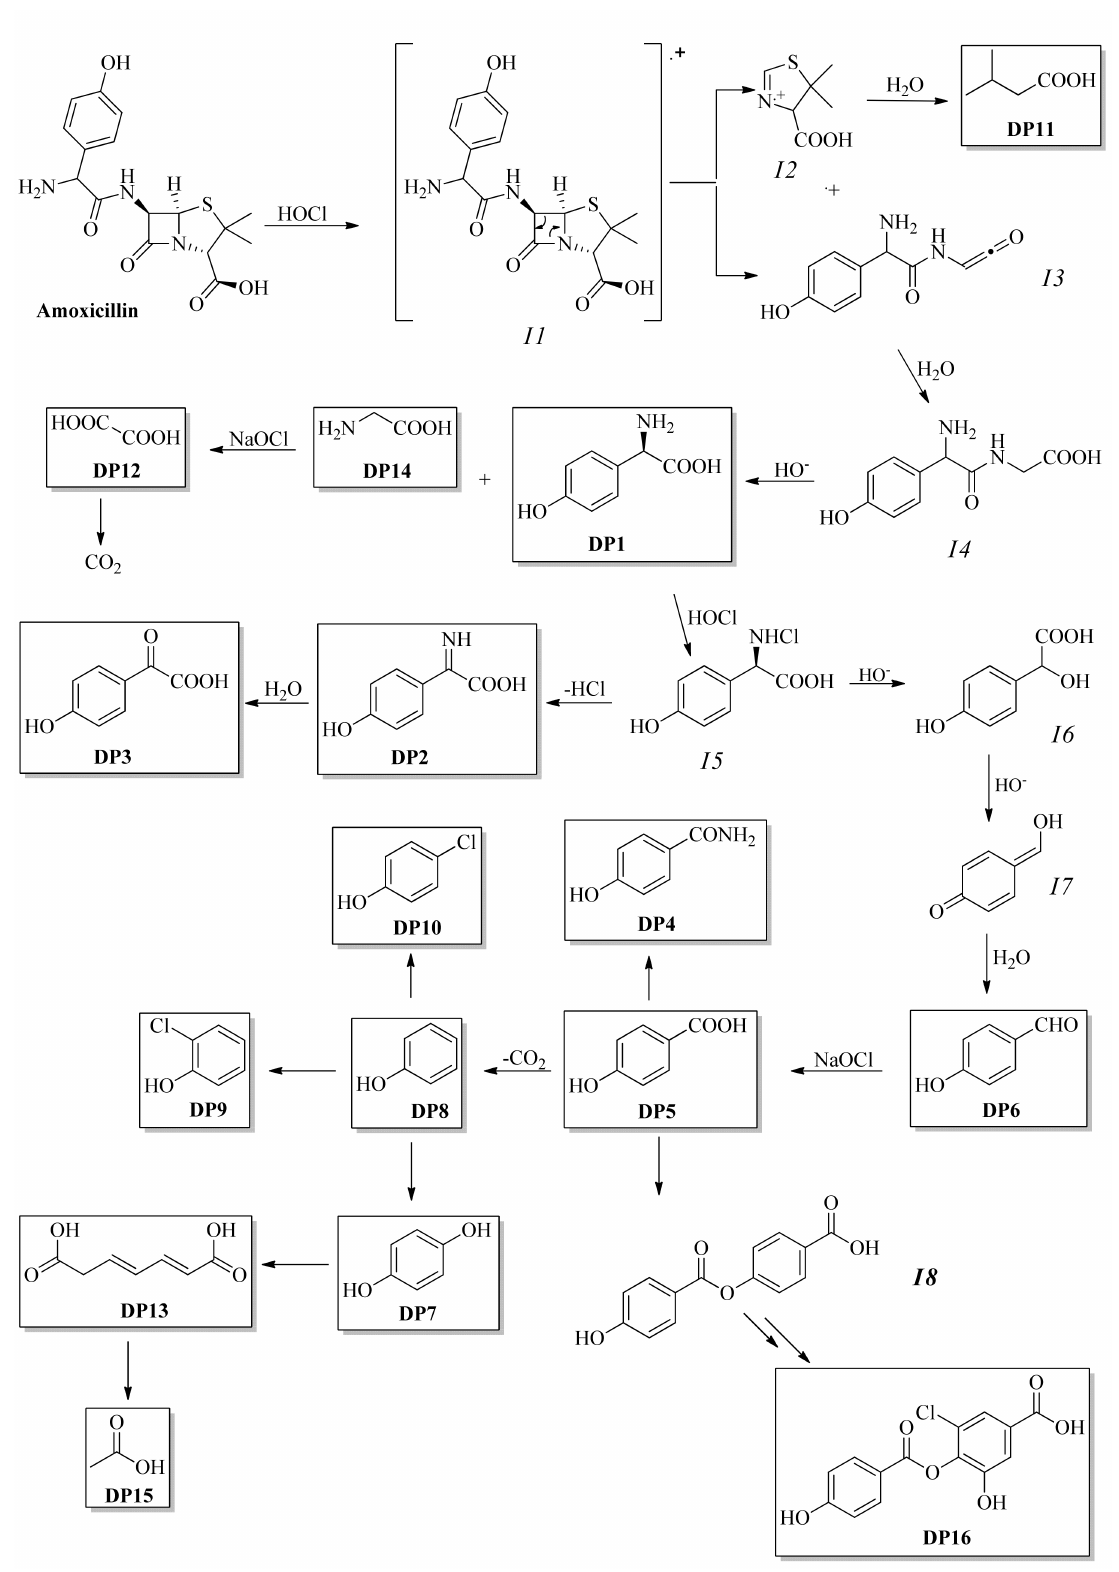
Figure 4. Plausible mechanism for the formation of DP1—DP16. The aqueous fraction (W, 959 mg) was dried by lyophilization, re-dissolved in methanol, and separated with the silica gel CC using a gradient of ethyl acetate/methanol (100:0 to 0:100, v / v ) to yield 27 fractions. The fraction W8 (39 mg), eluted with ethyl